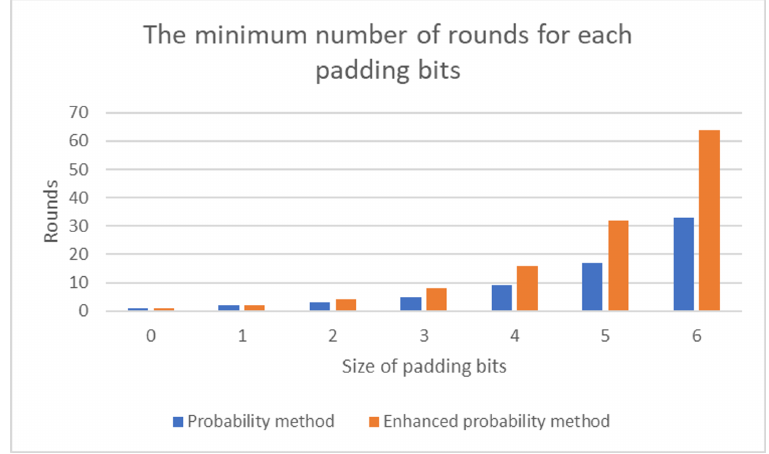
Figure 19. Number of minimum rounds for each size of appended bits.